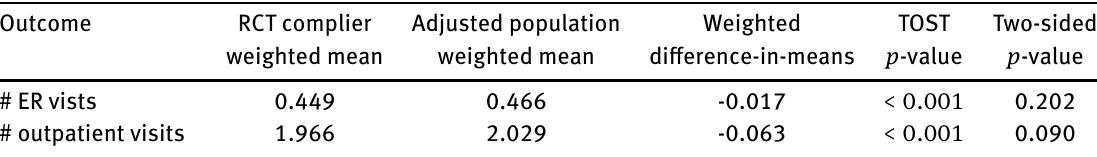
Table B3: Placebo